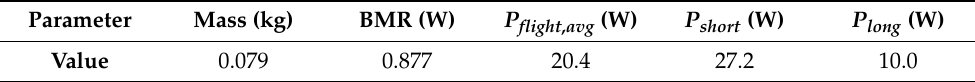
Table 1. Energy and mass data for the Common